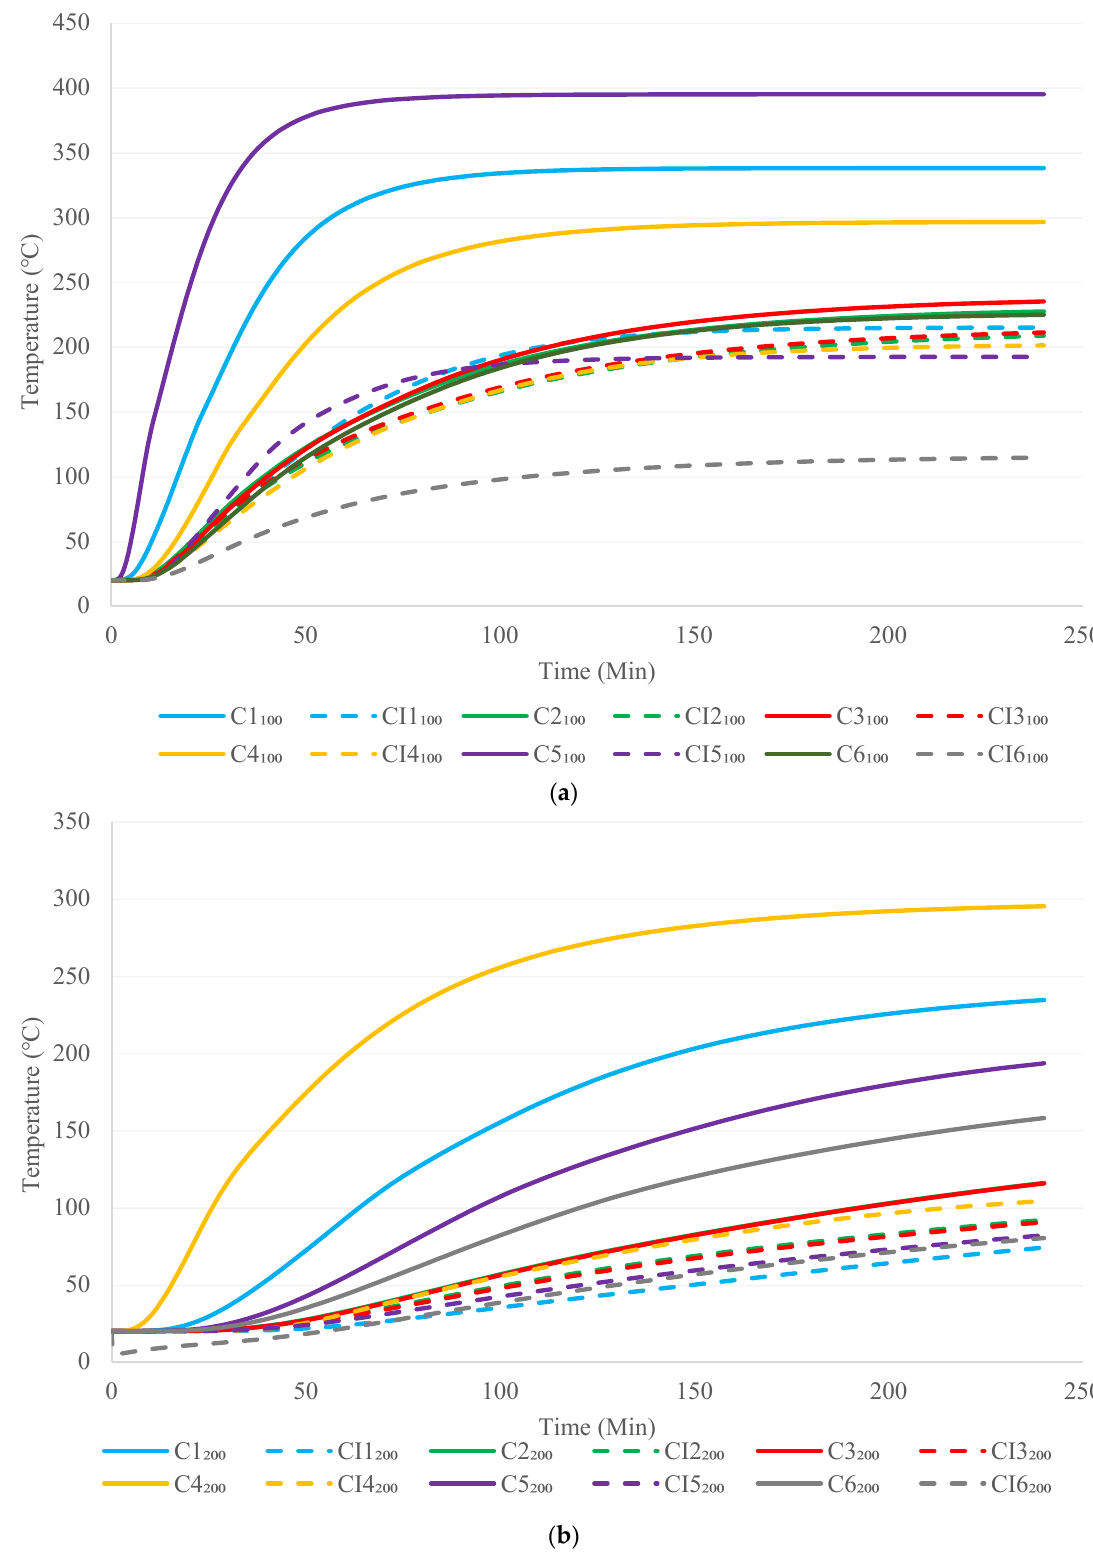
Figure 10. ( a ) Unexposed surface temperature variation of 100 mm wall configurations subjected to hydrocarbon fire. ( b ) Unexposed surface temperature variation of 200 mm wall configurations subjected to hydrocarbon fire.